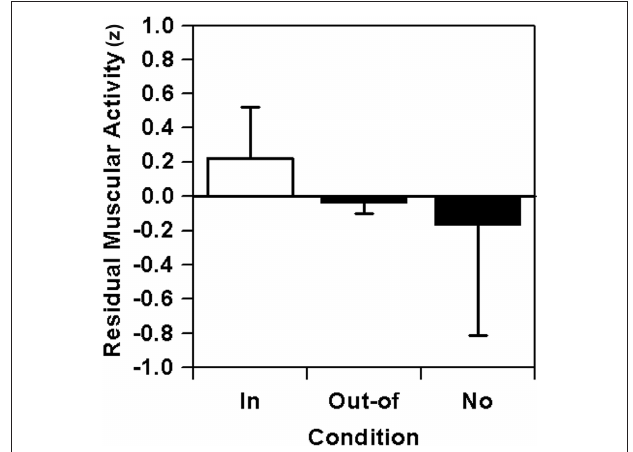
Figure 6 | Lever sequencing: residual relative muscular activity (eA) after removal of quadratic trends and combined across the six nodal points as a function of focus of attention on the nodal point (in-focus), on any other nodal point (out-of-focus), or without any special instruction